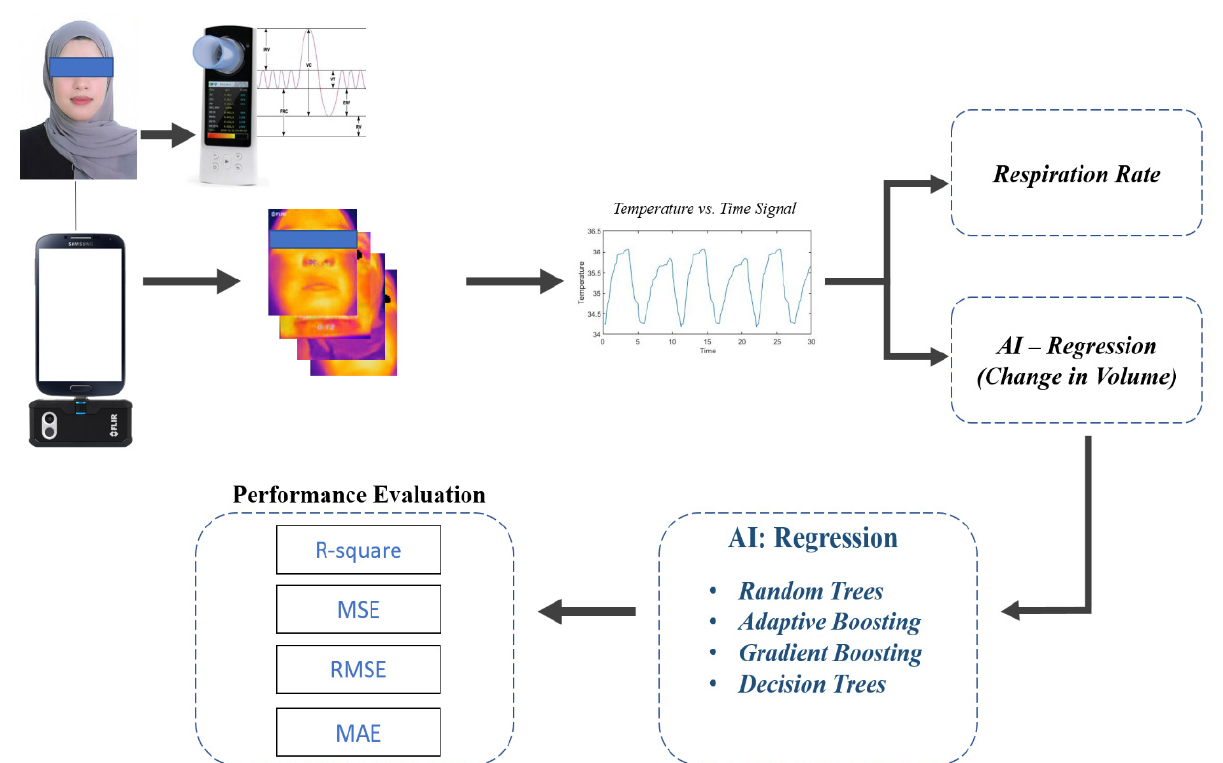
Figure 1. Graphical abstract of the proposed work.